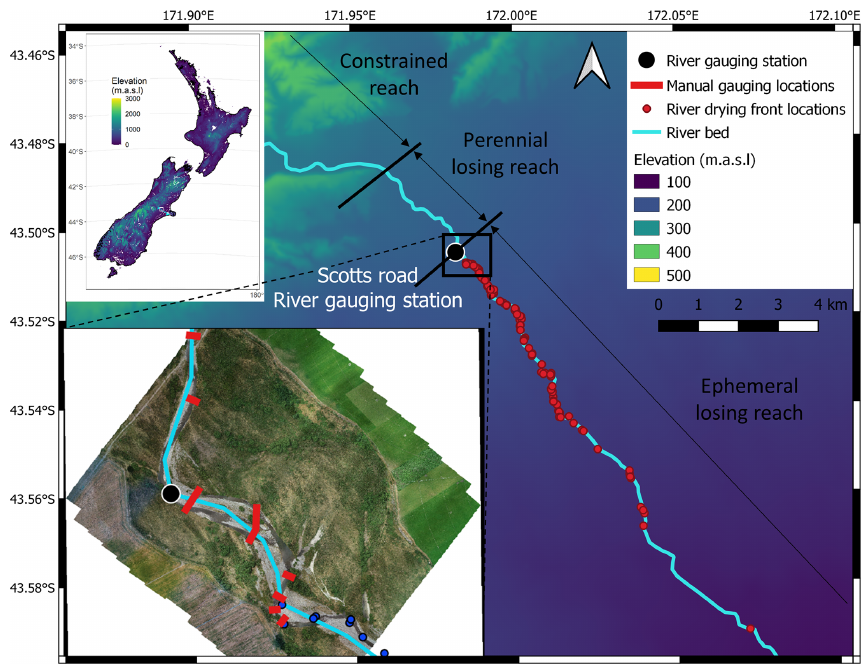
Figure 1. Map of the Selwyn River with the river gauging monitoring station, the eight manual gauging cross sections and the 153 river drying front locations. The different reaches were delimited according to Larned et al. (2008).